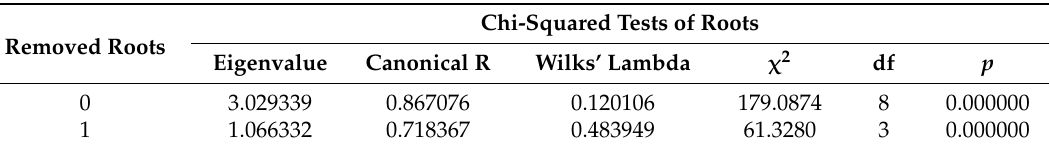
Table 6. Chi-squared test results for subsequent